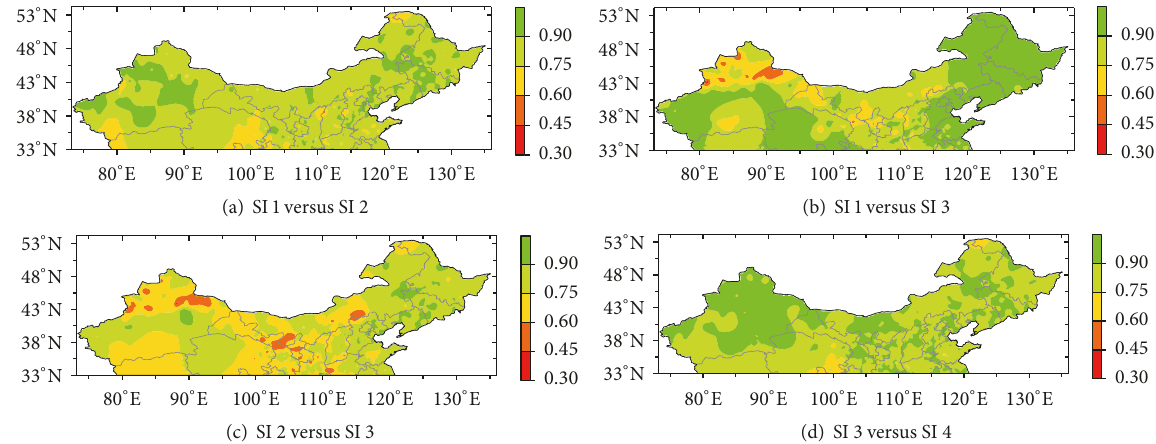
Figure 2: Correlation coefficients for combinations of the start indices of growing season in northern China.